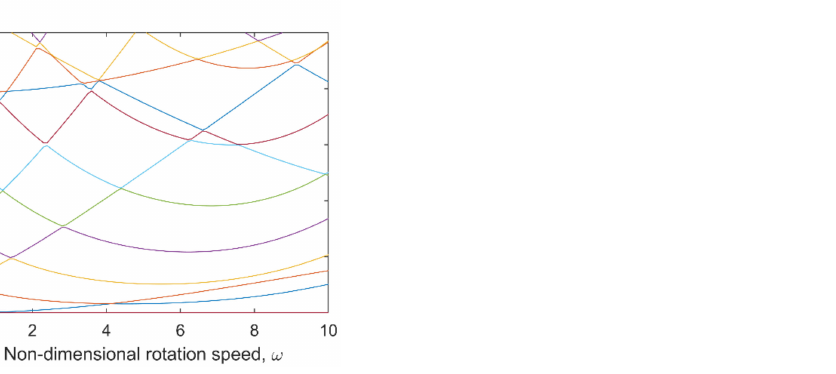
Figure 2. The dimensionless natural frequencies with respect to dimensionless rotation speed with the parameters in Reference [22].